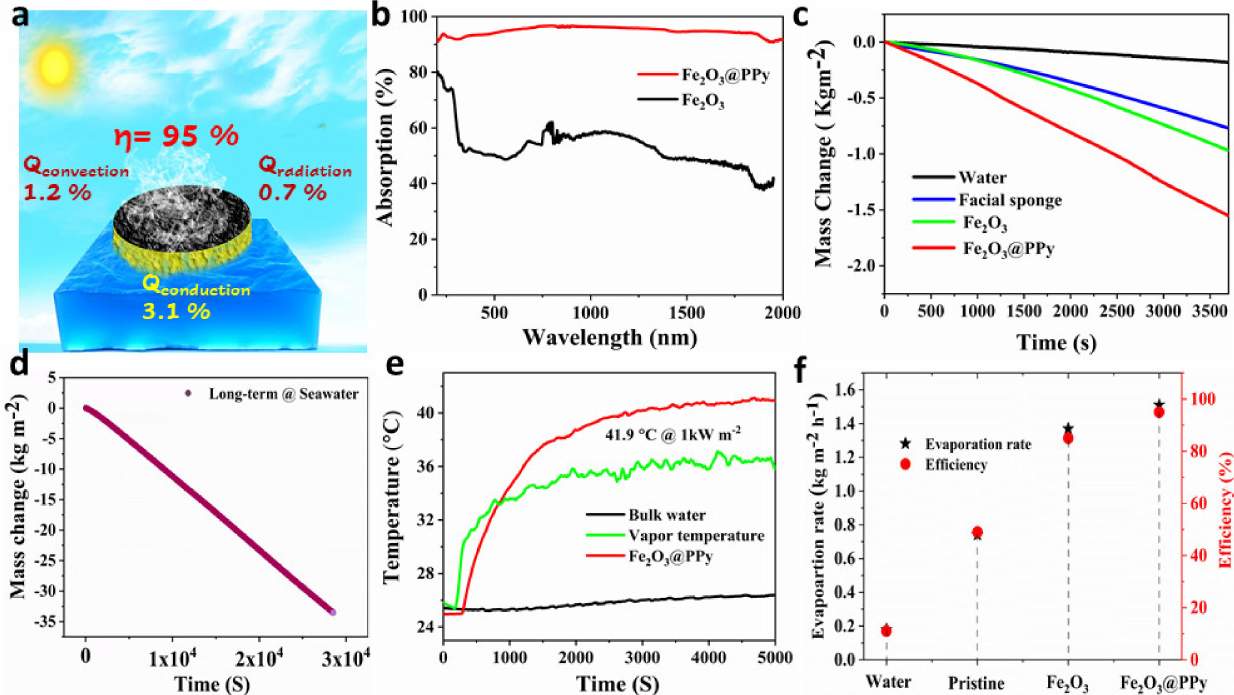
Figure 5. ( a ) Energy balance diagram of Fe 2 O 3 @PPy solar evaporator with conductive, convective, and radiative losses. ( b ) Full range of the UV-Vis absorption spectrum of Fe 2 O 3 and Fe 2 O 3 @PPy solar evaporator. ( c ) Mass change in water, facial sponge, Fe 2 O 3 /facial sponge, and Fe 2 O 3 @PPy solar evaporators under one sun illumination. ( d ) The long-term evaporation performance with minor disparity under one sun irradiation for continuous evaporation up to 8.3 h in seawater conditions. ( e ) Surface temperatures of Fe 2 O 3 @PPy solar evaporator and vapors. ( f ) The achieved evaporation rates and respective solar to vapor conversion efficiencies of the designed four evaporation